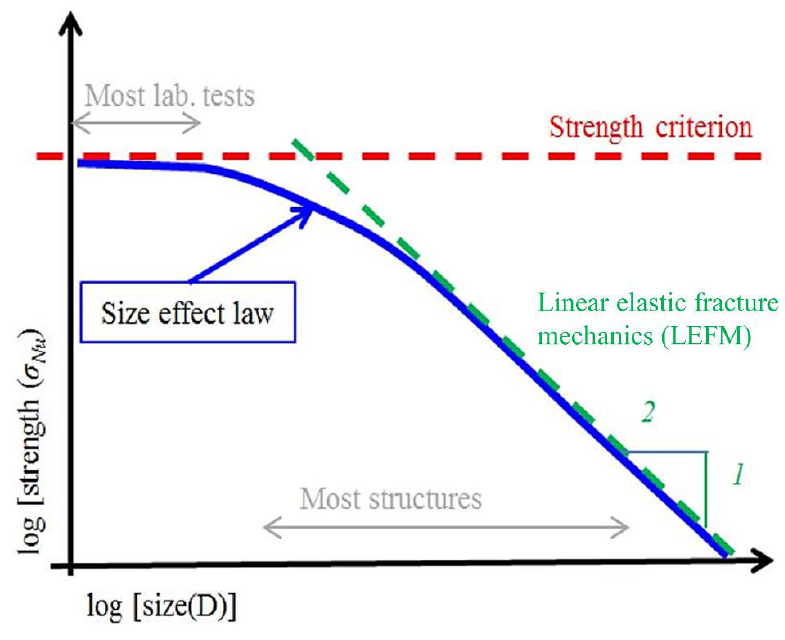
ff ect on member strength (adapted from Reference Figure 1. Size effect on member strength (adapted from Reference [18]). Figure 1. Size e